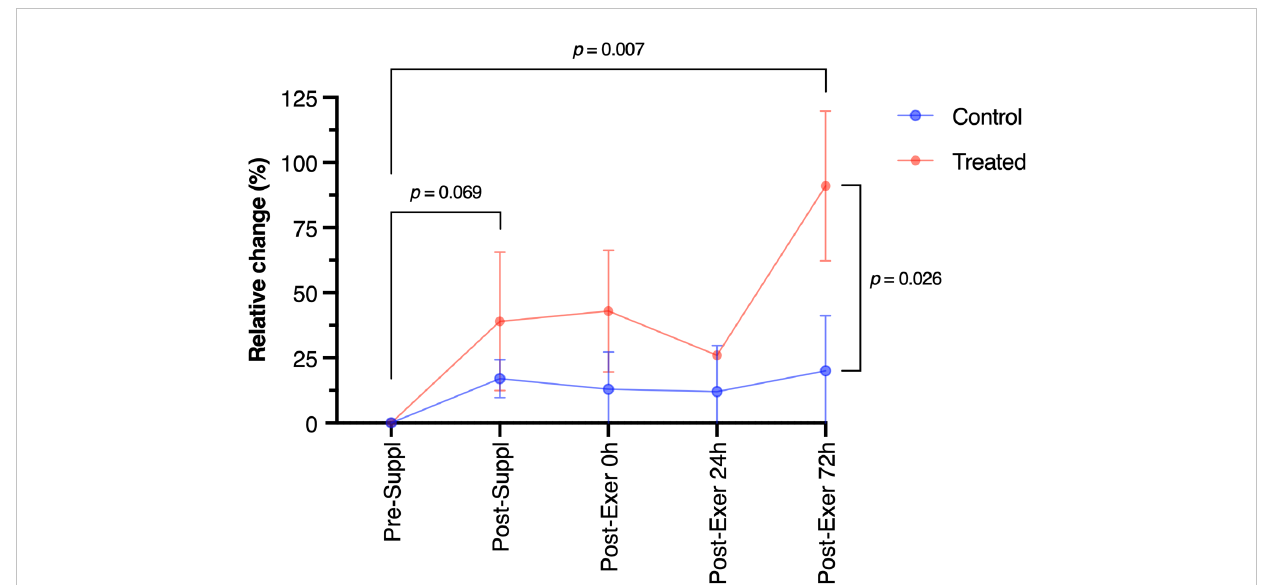
FIGURE 3 Immunoglobulin A (sIgA) relative change along the study period. Phase refers to before the supplementation period (pre-suppl), after 30 days of supplementation (post-suppl), immediately after the last training session (post-exer 0h), and the remaining time-points refer respectively to 24h and 72h after the last training session (post-exer 24h and 72h). Orange dots are about the treated group, while blue dots are about the control group.